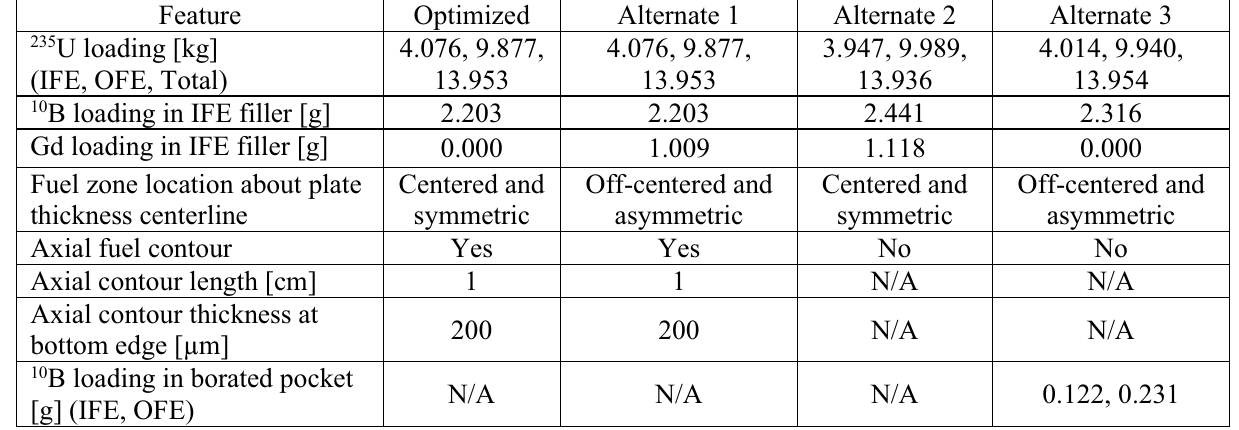
Table I. Conceptual design feature descriptions.